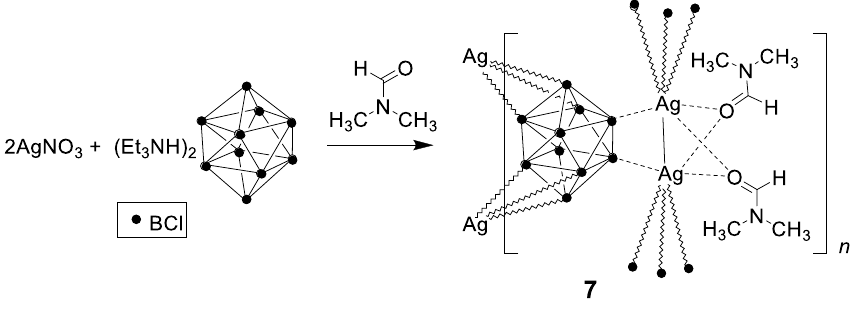
Figure 4. (a) Asymmetric unit of 6 and ( b ) closest environment of ions in representation of atoms with thermal ellipsoids ( p =